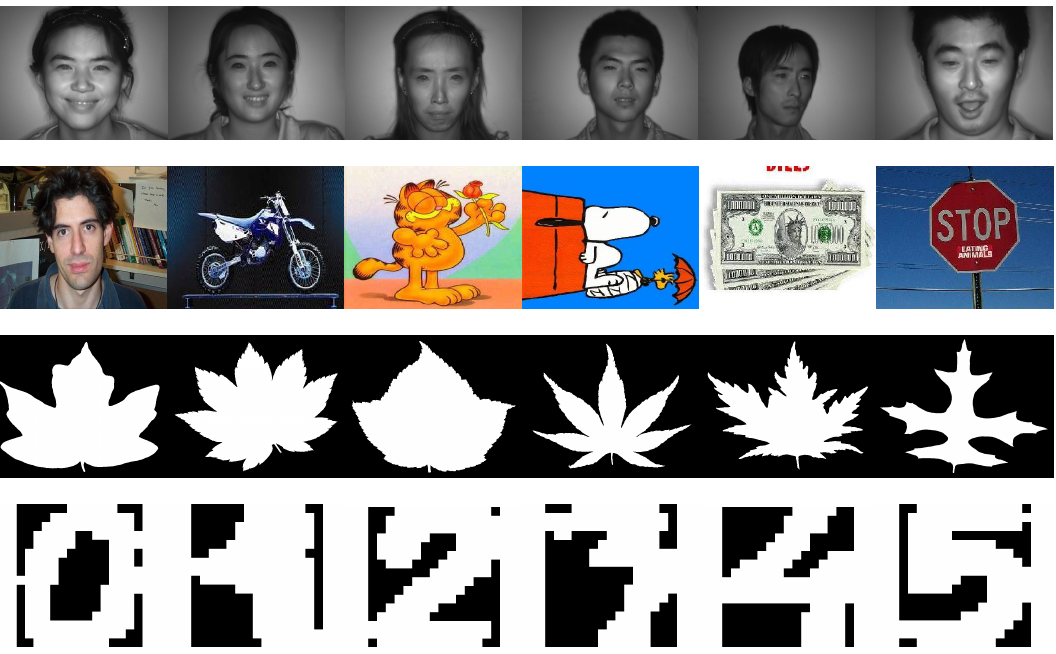
Figure 2. Sample images of the four datasets. Row from top to bottom represents images from BUAA, Caltech7, 100Leaves and Mfeat,